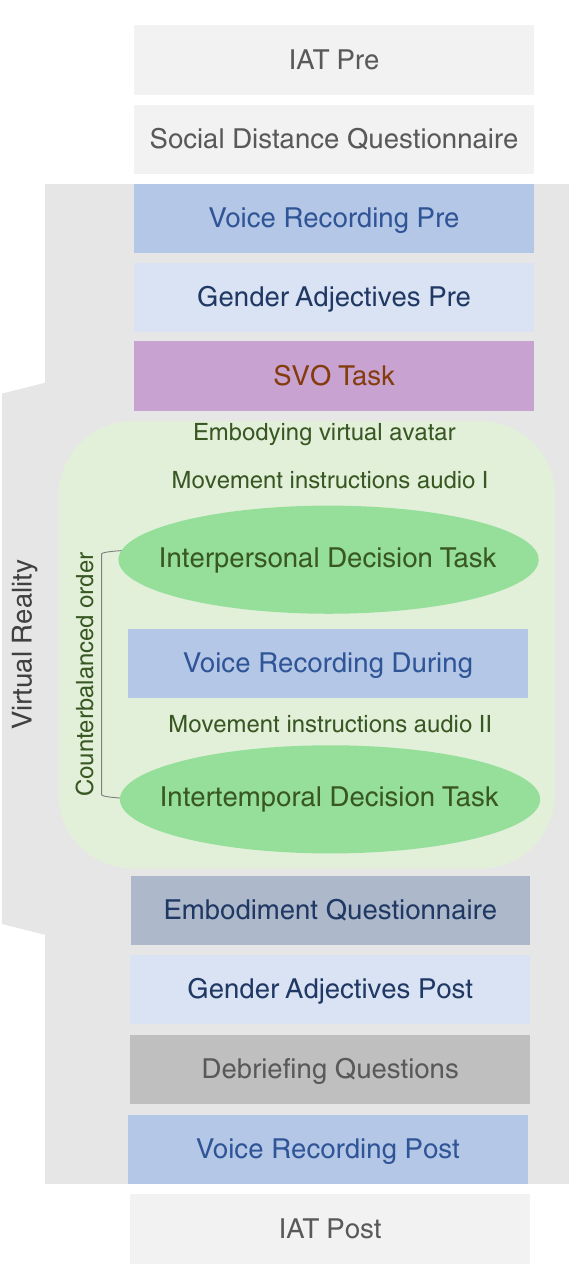
Figure 2. Experimental procedure. Overview of the experimental procedure. IAT implicit association test, SVO social value